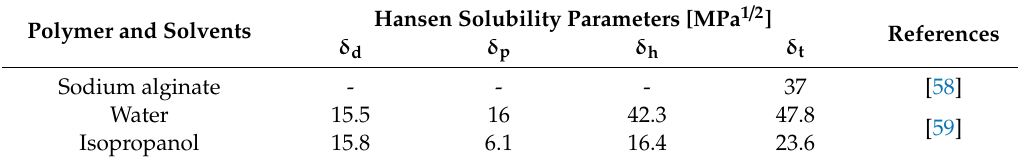
Table 2. Hansen’s Solubility